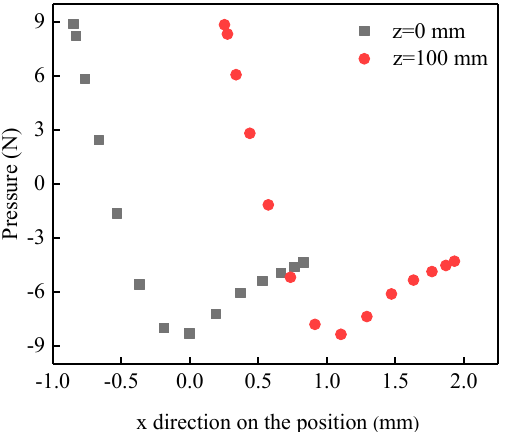
Figure 9. Scatter plot of pressure variation with the position in x-direction at z = 0 section and z = 100 section position.